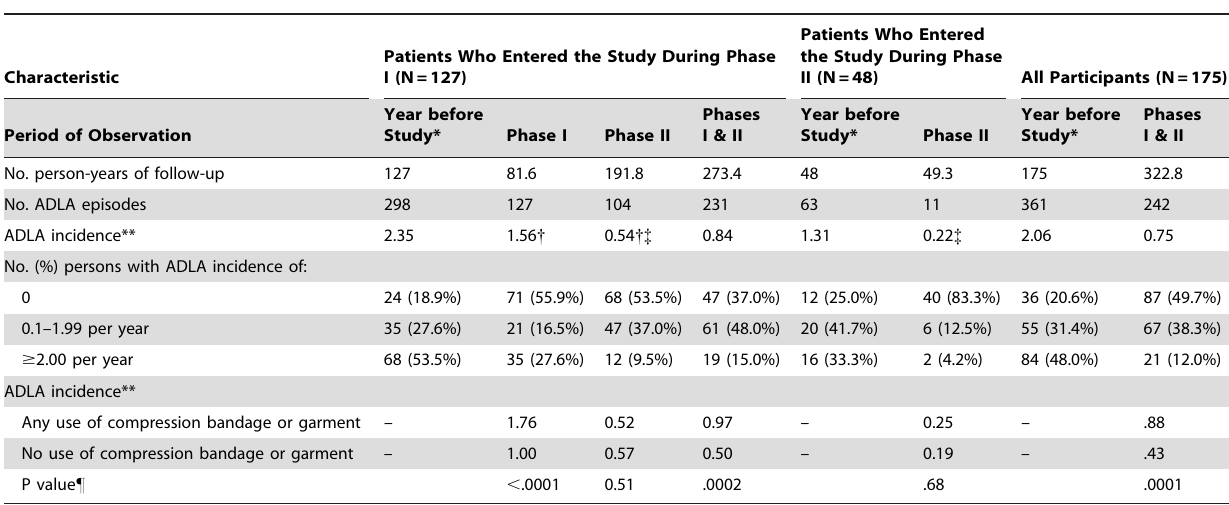
Table 3. Acute dermatolymphangioadenitis (ADLA) among the 127 lymphedema patients who entered the study during Phase I (before April 1, 1997); for the 48 who entered the study during Phase II (after April 1, 1997); and for all 175 participants combined, univariate